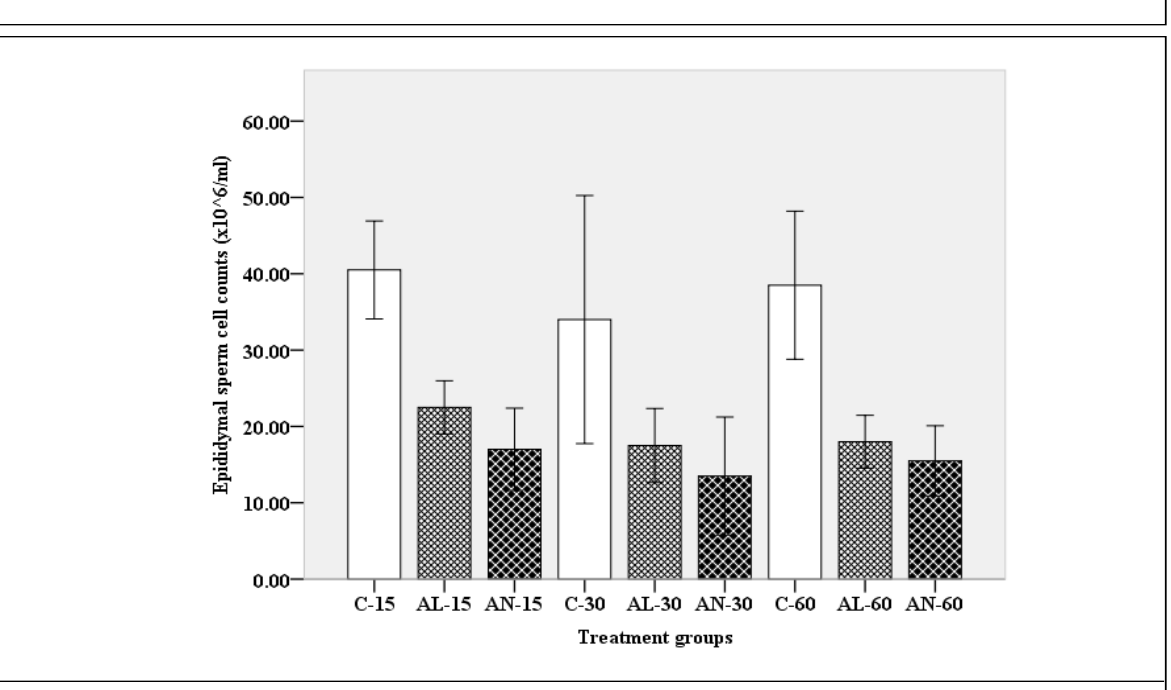
Figure 4: Effect of crude plant extract in feed on the epididymal sperm cell counts following its treatment for 15, 30, or 60 days in the M. natalensis male rats. C = control groups, AL= A. lebbeck stem bark methanolic extract, AN = A. nilotica pods methanolic